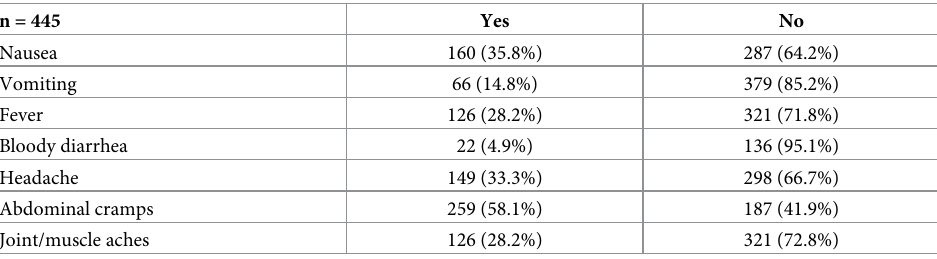
Table 3. Symptoms associated with